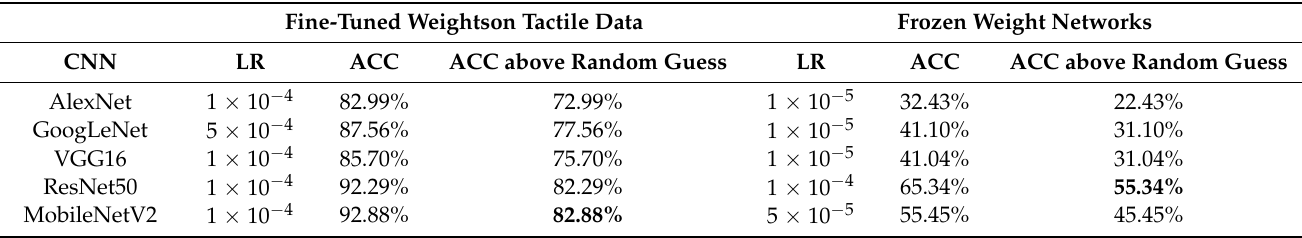
Table 1. Classification results for VT-60 dataset. All networks are trained on a minimum batch of size 16 and for 20 epochs.